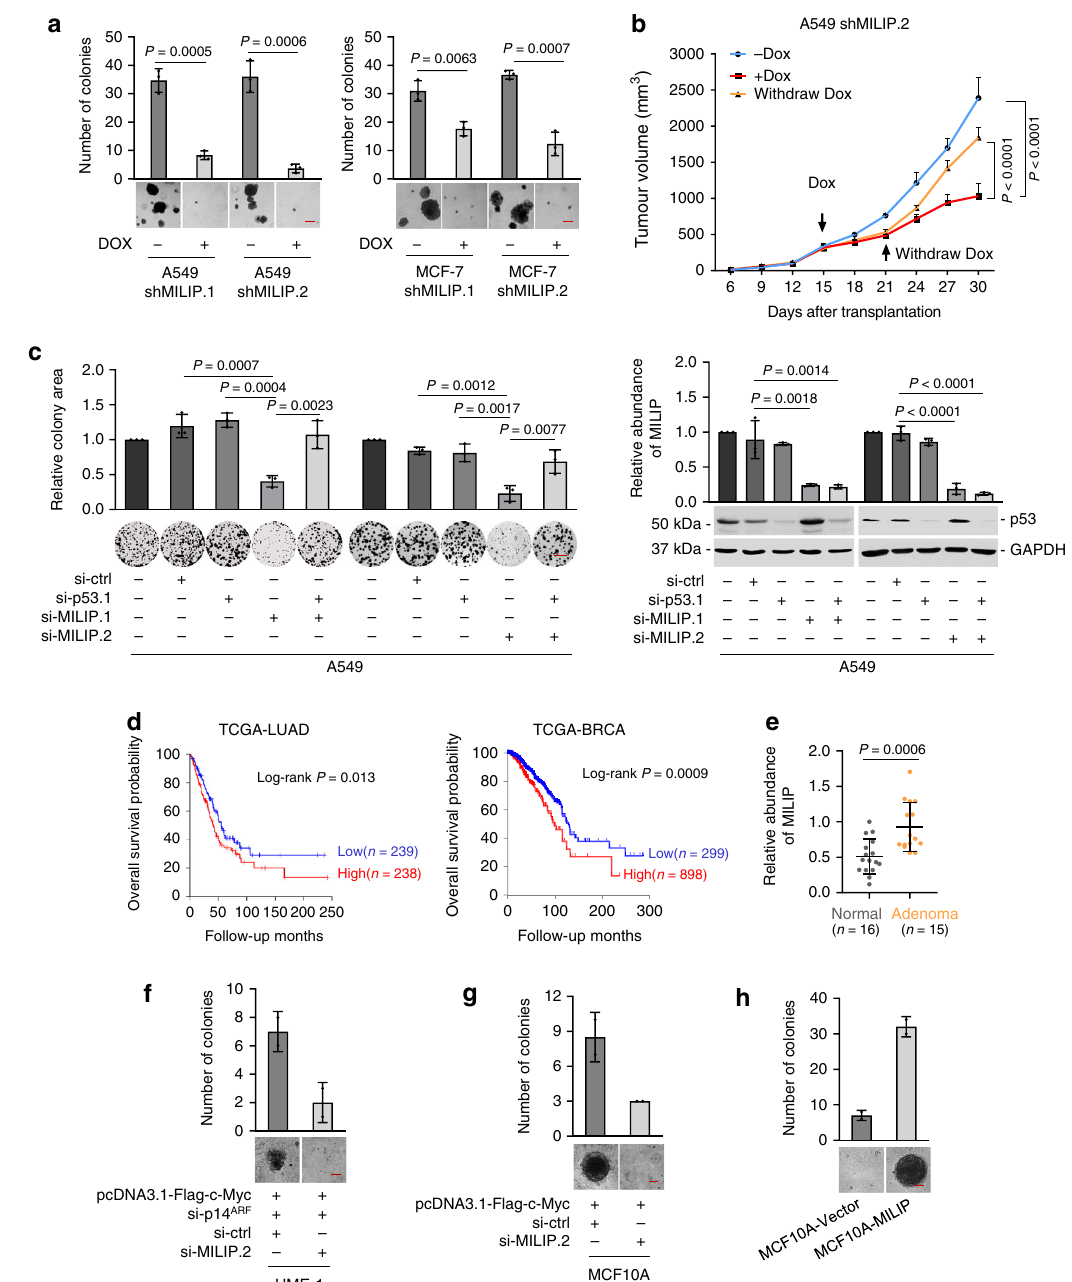
Fig. 2 MILIP promotes tumorgenicity. a Induced knockdown of MILIP by DOX reduced cancer cell anchorage-independent growth. Scale bar, 50 µ m. Data are representatives or mean ± s.d.; n = 3 independent experiments, two-tailed Student ’ s t test. DOX: 200 ng/mL. b Induced knockdown of MILIP by DOX retarded A549 xenograft growth, which was reversed by DOX withdrawal in nu/nu mice. Data are mean ± s.d.; n = 6 mice per group, one-way ANOVA followed by Tukey ’ s multiple comparison test. DOX: 2 mg/mL supplemented with 10 mg/mL sucrose in drinking water. c MILIP silencing reduced A549 cell clonogenicity, which was attenuated by co-silencing of p53 siRNA1. Scale bar, 1 cm. Data are representatives or mean ± s.d.; n = 3 independent experiments, one-way ANOVA followed by Tukey ’ s multiple comparison test. d Kaplan – Meier analysis of the probability of overall survival (OS) of lung adenocarcinoma (LUAD; n = 477) and breast invasive carcinoma (BRCA; n = 1197) derived from the TCGA using the median/quartile of MILIP levels as the cut-off. e MILIP expression was increased in colon adenomas ( n = 15) compared with normal colon epithelia ( n = 16). Data are mean ± s.d.; two-tailed Student ’ s t test. f MILIP silencing decelerated anchorage-independent growth of HME-1 human mammary epithelial cells caused by c-Myc overexpression along with knockdown of p14 ARF . Scale bar, 50 µ m. Data are representatives or mean ± s.d.; n = 2 independent experiments. g MILIP silencing decelerated anchorage-independent growth of MCF10A human mammary epithelial cells that did not express p14 ARF caused by c-Myc overexpression. Scale bar, 50 µ m. Data are representatives or mean ± s.d.; n = 2 independent experiments. h MILIP overexpression caused anchorage-independent growth of MCF10A cells. Scale bar, 50 µ m. Data are representatives or mean ± s.d.; n = 2 independent experiments. Source data of Fig. 2a – h are provided as a Source Data fi